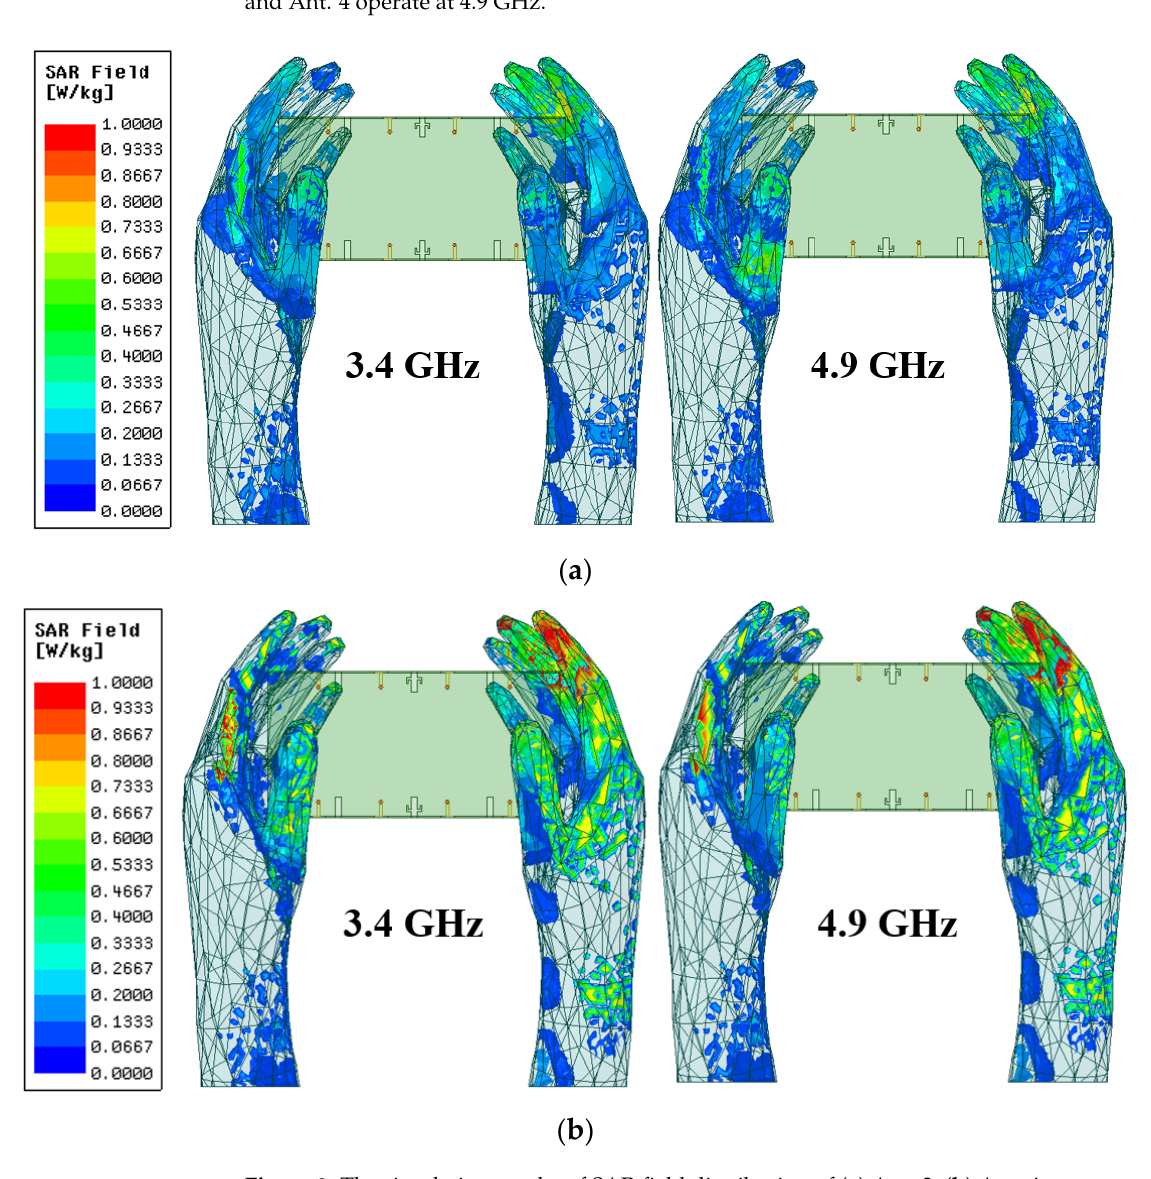
Figure 9. The simulation results of SAR field distribution of ( a ) Ant. 3; ( b ) Ant. 4.